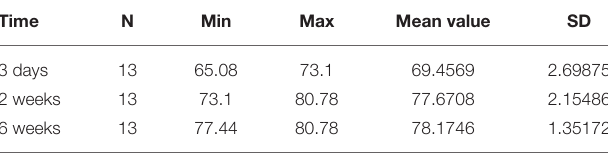
TABLE 2 | Descriptive statistics for the ISP population.